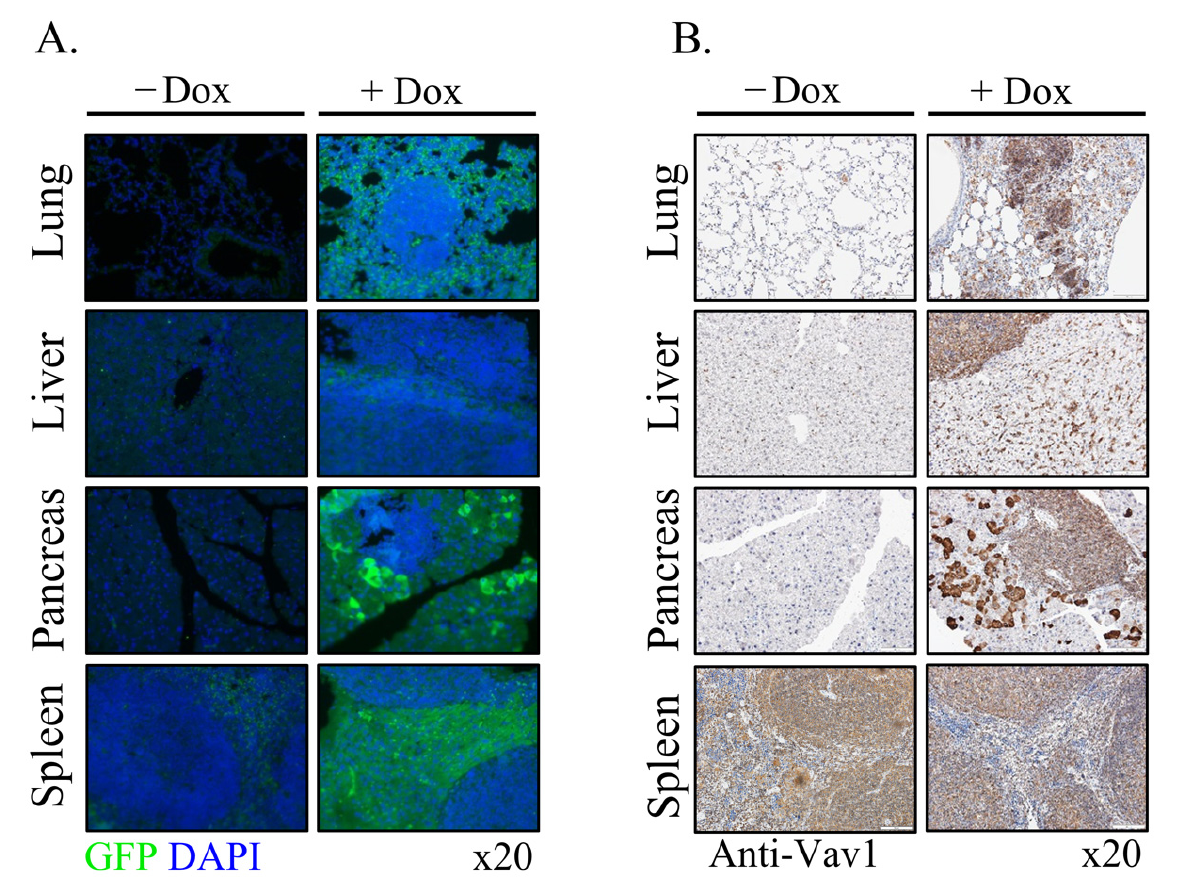
Figure 4. Expression of transgenic human Vav1(indicated by GFP) in the epithelial tissue at various organs of Rosa Vav1 mice. Sections of lung, liver, pancreas, and spleen from Rosa Vav1 mice either treated (+Dox) or non-treated ( − Dox), Dox 12 months post transgene induction were stained with anti-GFP antibodies that identify the human Vav1 transgene (immunofluorescence; green) ( A ) or anti-Vav1 antibodies that identify murine and human Vav1 ( B ). Representative pictures are shown. Magnification at ×20.